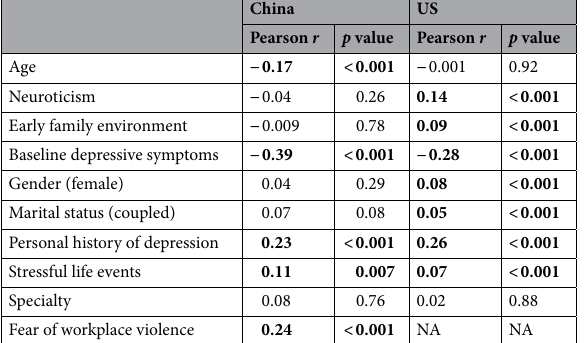
Table 2. Baseline predictors of change in PHQ-9 score during residency (average across all 4 follow-ups) in China and the US. Significant correlations are bolded. NA not available. All significant factors in the model are bolded.